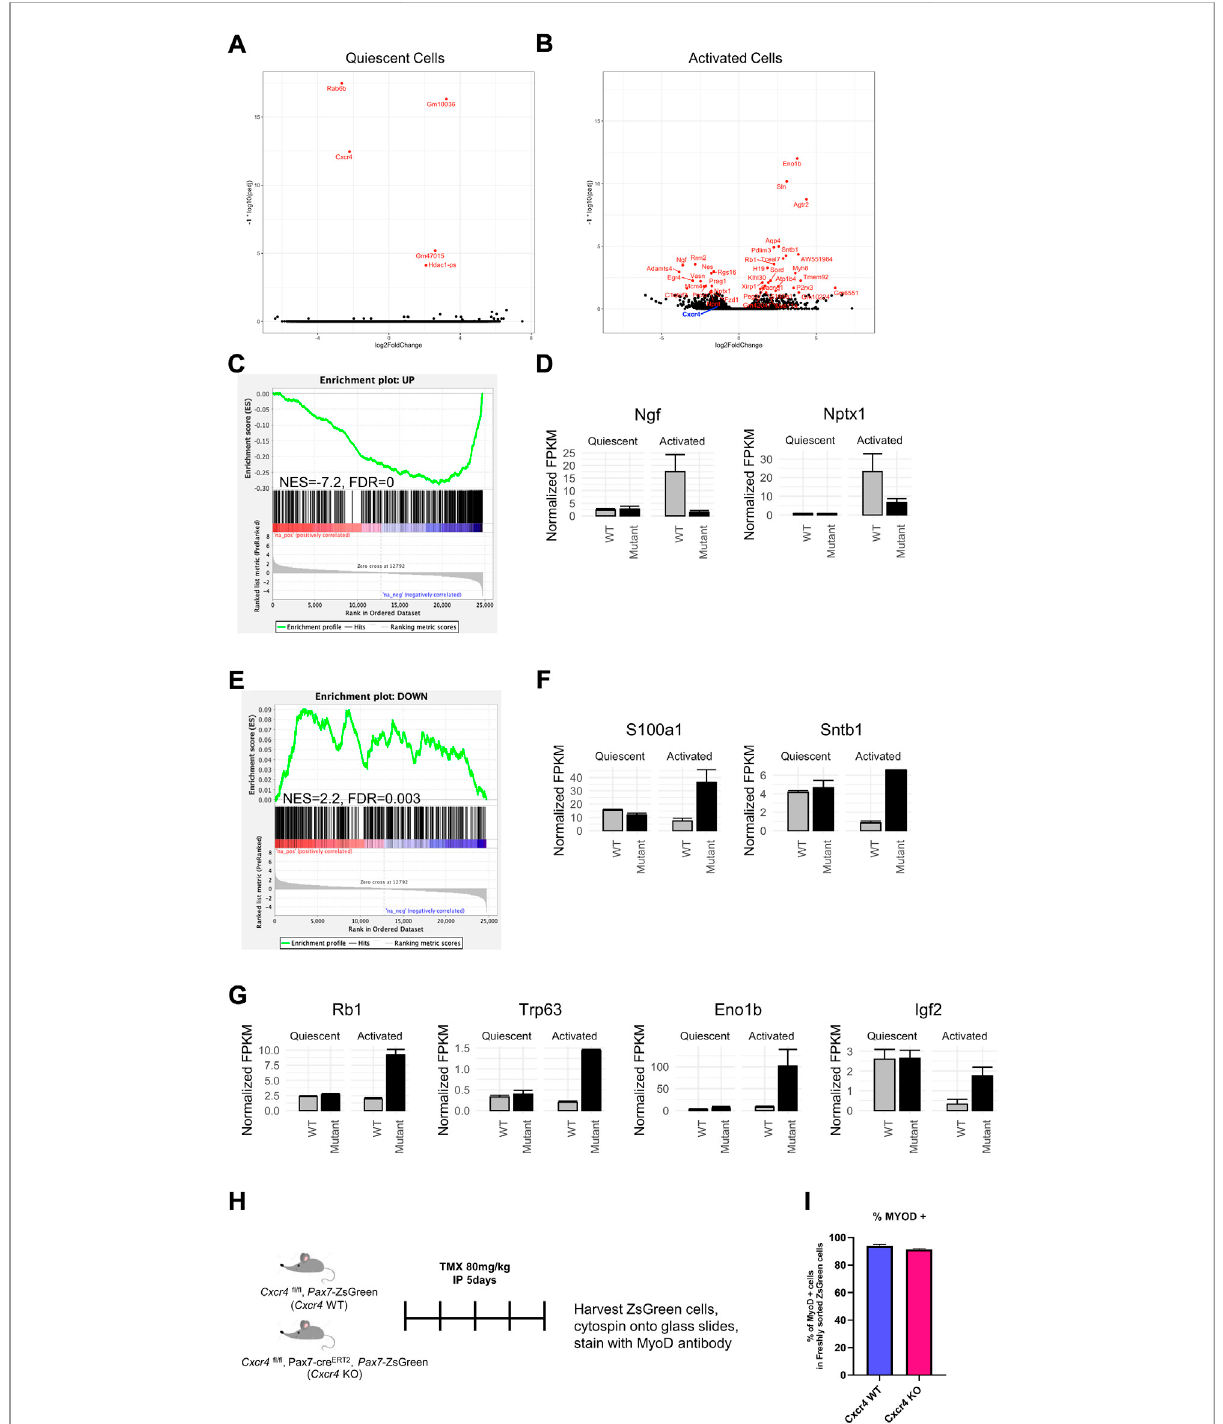
FIGURE 6 CXCR4 mediates the satellite cell early activation but not quiescence transcriptional pro fi le. (A) Volcano plot showing differentially expressed genes in freshly isolated Cxcr4-KO PAX7 or WT satellite cells from steady state muscle. The -log10 p-value and log2 fold changes of genes in Cxcr4 knockout cells compared to controls are plotted such that genes that are more highly signi fi cant are higher on the y-axis. (B) Volcano plot showing differentially expressed genes in Cxcr4-KO PAX7 or WT satellite cells undergoing activation (overnight culture in MGM). (C) Gene set enrichment analysis (GSEA) for changes betweenCxcr4-KO PAX7 and WT compared to wild type in theactivated state, using a set of genes previously determined to be upregulated with activation (Machado et al., 2017). (D) Barplots of example genes that were within the activation-UP gene set with